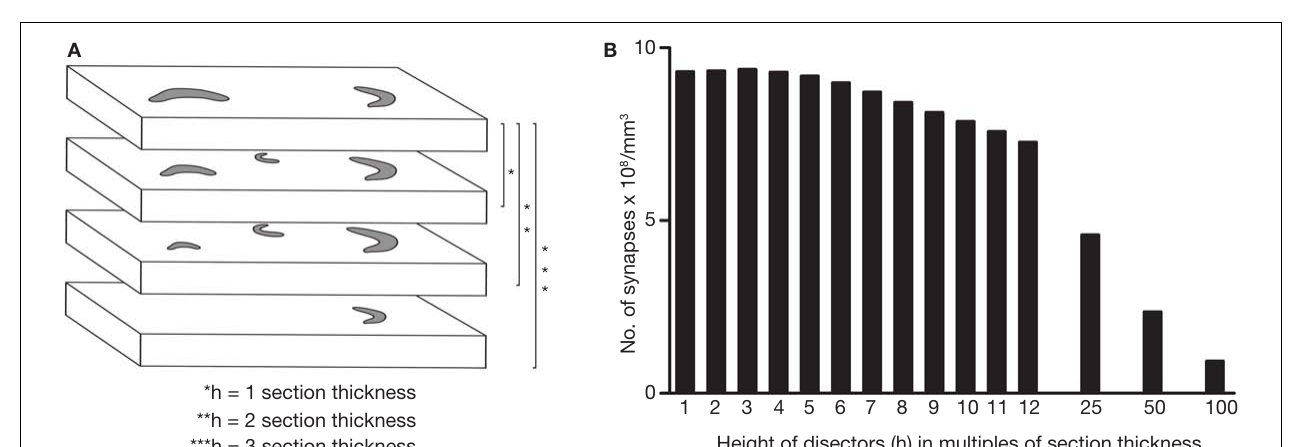
Although the pre and post-synaptic densities and the synaptic cleft cannot be individually resolved, the prominent thickness of the density (asterisks) strongly suggests that it is an asymmetric synapse. Thanks to the tilted angle of section (13 ° ), a nearby asymmetric synapse can also be identifi ed in (D) (arrow). This small synapse is the same that has already been shown in Figure 7 (H) to (L) where it can also be easily identifi ed as an asymmetric synapse. The apparent loss of image quality in (B) to (E) is due to the fact that resolution in z -axis is limited by the section thickness of 19.9 nm. Scale bar, 500 nm.